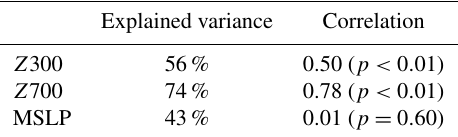
Table 1. Correlation coefficients computed between the first and second principal components of MSLP, geopotential height at 300 and 700hPa and the first principal component of the organic matter AOT. P values are indicated in